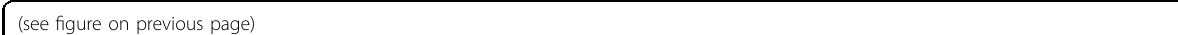
Fig. 1 Effects of LPS on HMC3 microglia. A Representative phase-contrast images show morphological changes in HMC3 microglia after 24 h incubation with different doses of LPS. Scale bar, 500 μ m. B Immuno fl uorescence staining for CD11b (green fl uorescent signal), phalloidin (white), and nuclear DAPI staining (blue) was performed. Scale bar, 49 μ m. C Cell viability after 24 h incubation with different doses of LPS was determined by the XTT assay. Values for each treatment are expressed as percentages of the corresponding control (cells untreated). The results shown are the mean ± SEM of triplicates. Double asterisks (**) indicate a signi fi cant difference from the LPS-activated group vs control ( p < 0.01). D LPS-induced ROS generation in HMC3 microglia cells in response to 24 h LPS exposure was determine using Celigo imaging cytometer. Representative images are shown. E Heat map showing relative cytokines expression. Collected supernatants were subject to cytokine array blots containing 30 different human neurologically relevant proteins. F Representation of relative cytokines expression. The values are shown as mean pixel